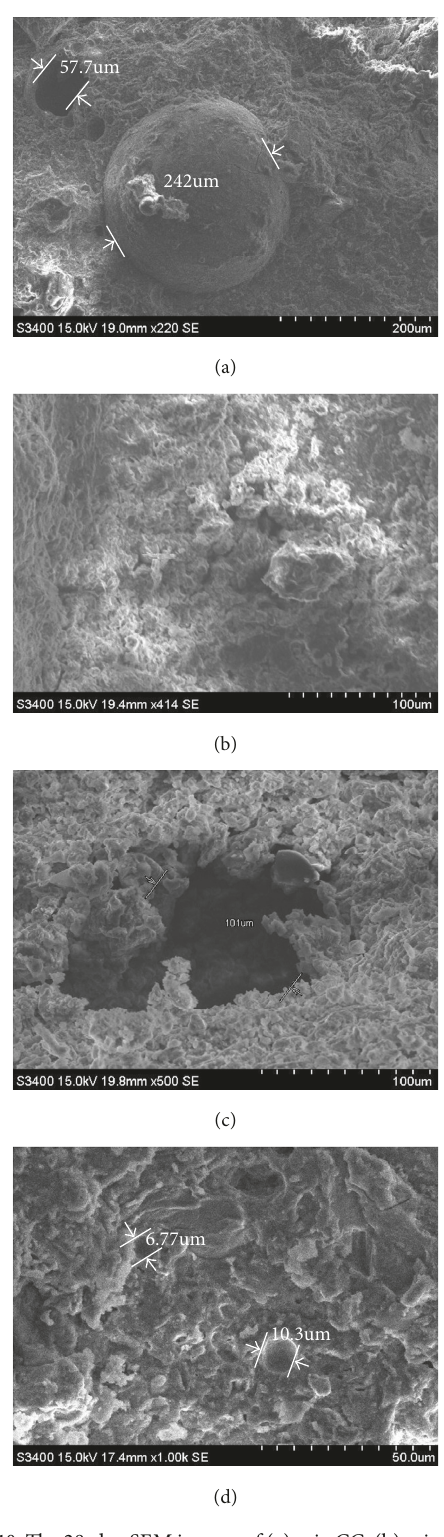
Figure 10: The 28-day SEM images of (a) mix CC, (b) mix CS60, (c) mix CS100, and (d) mix